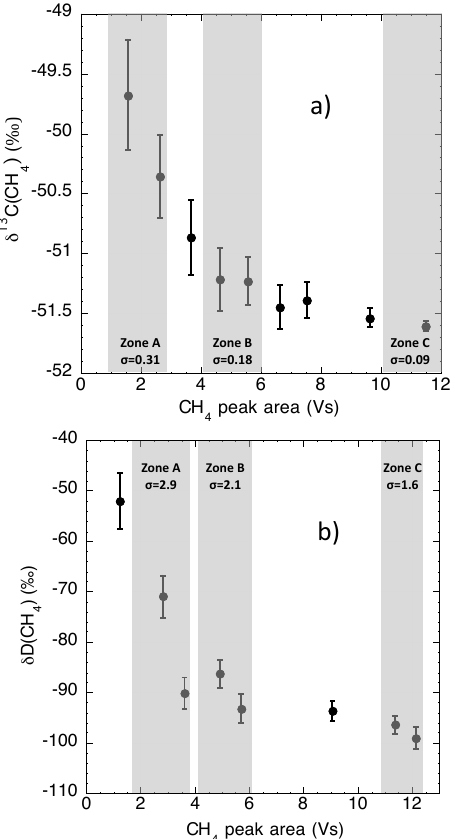
Fig. 4. Results from linearity tests for CH 4 isotopologues carried out twice a week during one month. Various amounts of reference air were introduced directly to the CH 4 IRMS system. Zone A cor- responds to peak areas where the small ice core samples of B30 were measured (200–350g for δ 13 C and 350–480g for δ D). Zone B corresponds to the “optimal zone” where larger ice samples ( ∼ 500– 700g) are measured. Zone C corresponds to standard reference air measurements. (a) δ 13 C(CH 4 ) (b) δ D(CH 4 ).